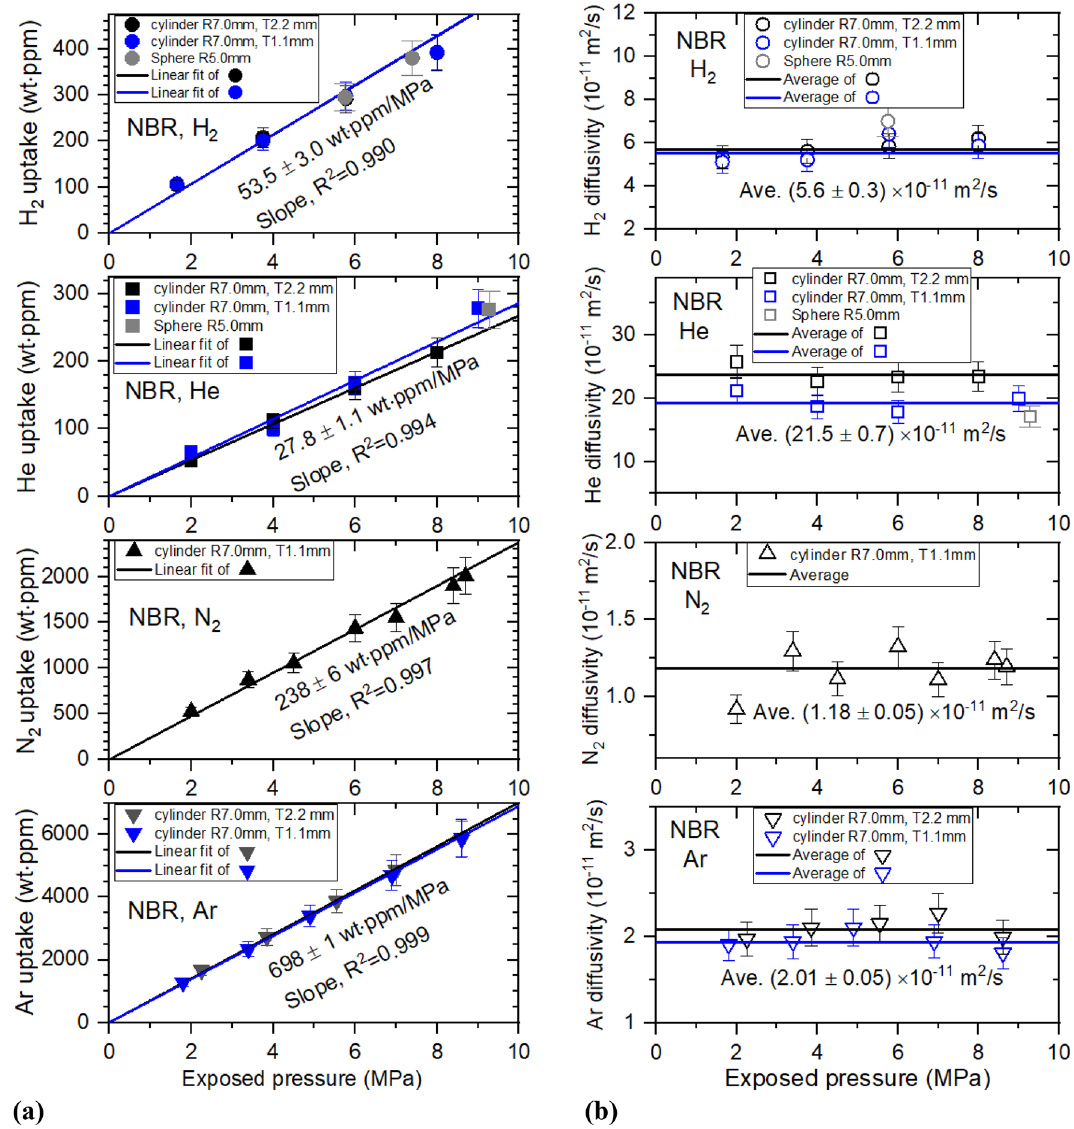
) and ( b ) diffusivity ( D ) versus exposed pressure for four gases in cylindrical- ∞